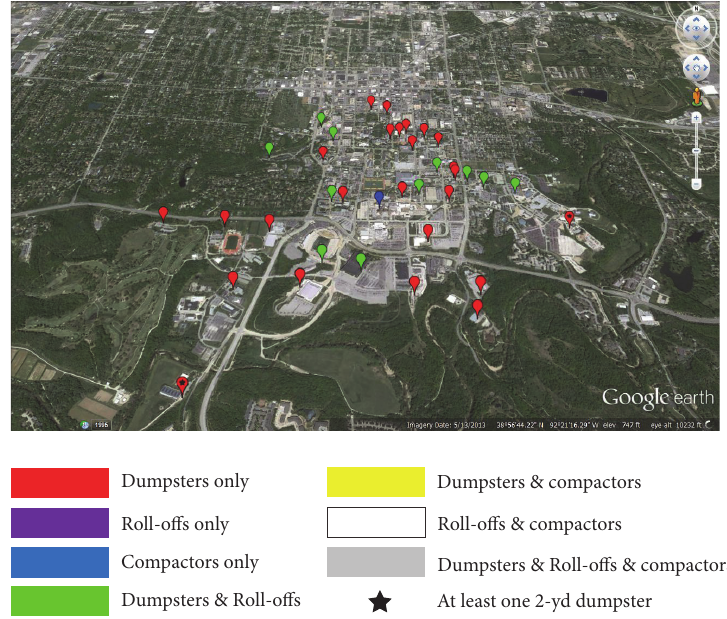
Figure 8: Distribution of receptacles around MU campus, highly robust ( 𝜂 = 100 ) solution, maximum transport distance of 0.25